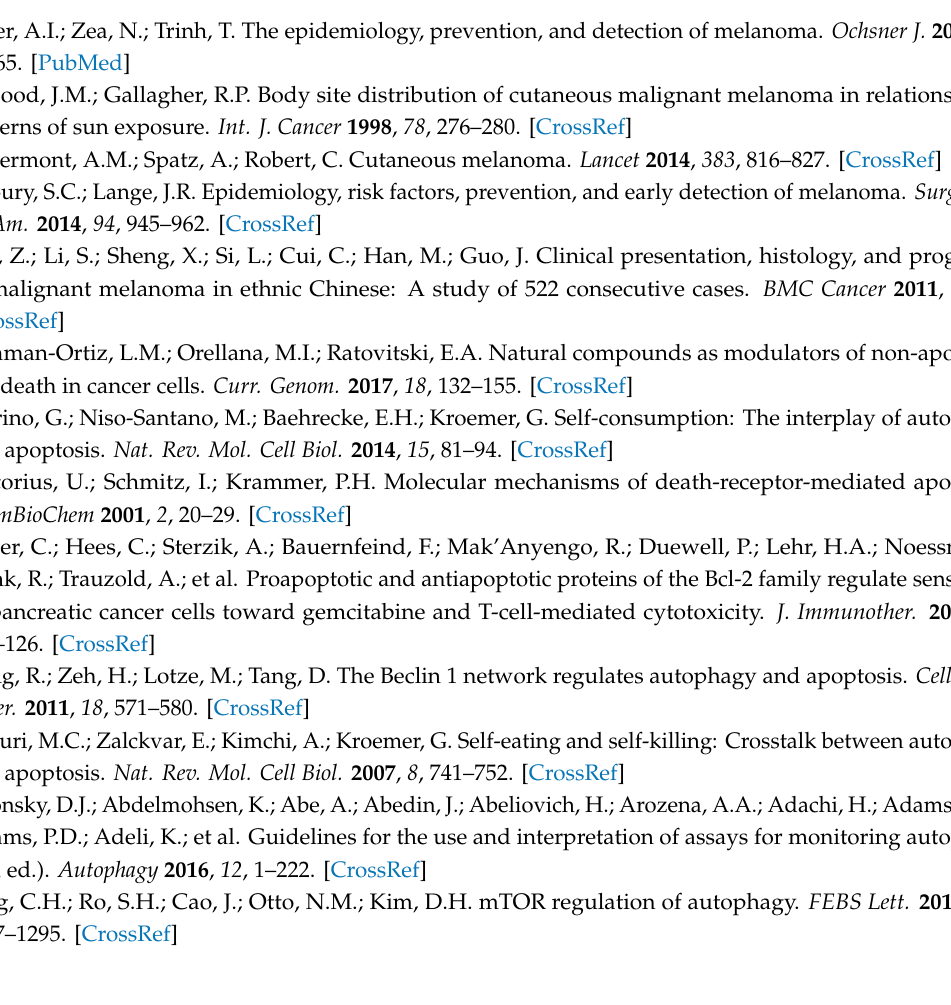
cells. Figure S2E: The e ff ect of time on the expressions of Bax and Bcl-2 proteins in 10 µ g / mL of FKB treated A375. Figures S4A and S4B: A375 and A2058 cells were treated with various concentrations of FKB (0–10 or 0–15 µ g / mL, 24 h) to determine the conversion of LC3-I to LC3-II and expression of p62 proteins. Figure S6: FKB dysregulated Beclin-1, Bcl-2 ratio and suppressed p-AKT / p-mTOR expressions in melanoma cells. Beclin-1 and Bcl-2 expressions in A375 cells (S6A) and A2058 cells (S6B) and phosphorylation of AKT and mTOR proteins (S6C). Figure S10C: Measurement of LC3-I / II, caspase-3, and BRAF proteins both in the absence or presence of NAC pretreatment conditions. Figure S11A: E ff ect of time on the expression patterns of LC3-I / II and caspase-3 with response to FKB (10 µ g / mL, 0–24 h). Figure S11B–D: Expression of LC3-I / II and caspase-3 levels in di ff erent conditions. Cells were pretreated with caspase inhibitor (Z-VAD-FMK, 20 µ M) (S11B); early autophagy inhibitor (S11C); late autophagy inhibitor (S11D). Measurement of the expressions of LC3-I / II and caspase-3 proteins in LC3 knockdown cells